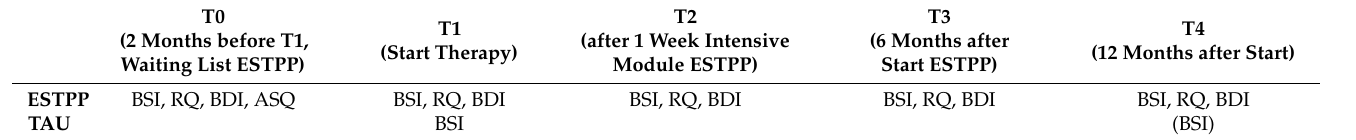
Table 1. Measurement time